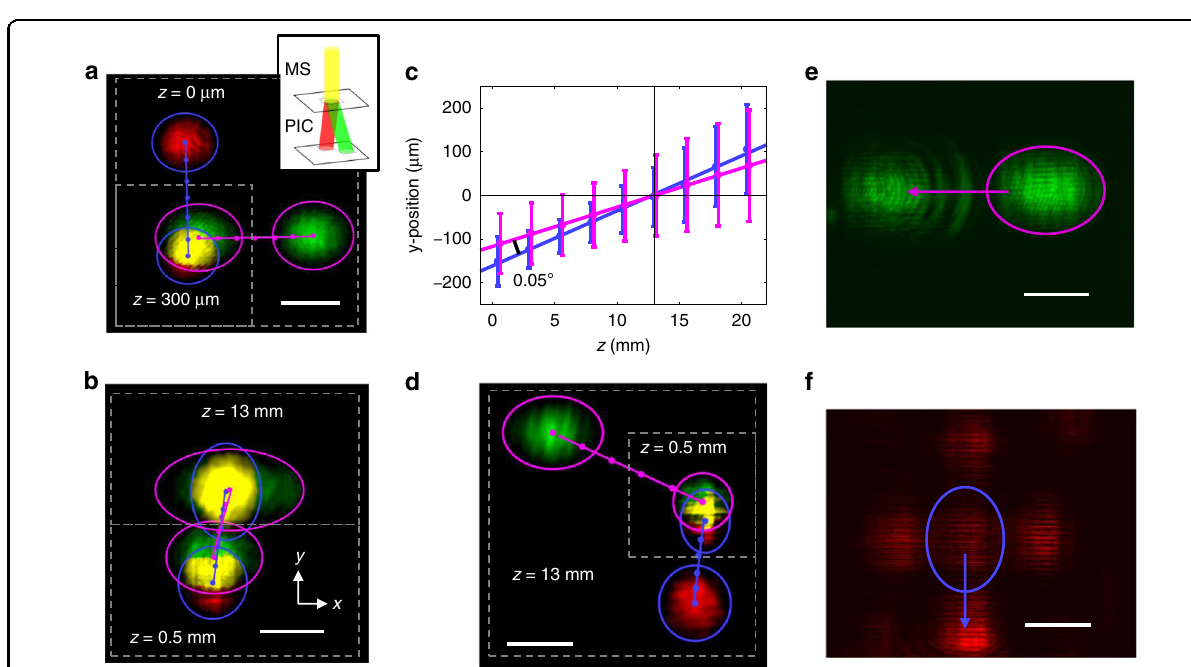
Fig. 4 Lattice and clock beam performance. a Composite image of the lattice (green) and clock (red) beams taken at the PIC surface (z = 0 µm, large white box) and the intersection height (z = 300 µm, small white box). The inset illustrates the ideal performance of the beam combiner. b Composite image of the lattice and clock beams measured at the MS surface (z = 0.5 mm, bottom white box) and near the MOT center (z = 13 mm, top white box). c Measured y-position of the lattice (magenta) and clock (blue) beams as a function of height above the MS. The vertical bars of the data points correspond to the average w 0 of the beams. d Composite image of the lattice and clock beams (similar to b ) for a MS that is mismatched by 1° in wedge correction. e Image of the desired negative-order lattice beam (circled) and zero-order beam (at arrow) taken 350 µm above the MS. f Image of the desired negative-order clock beam (circled), zero-order beam (at arrow), and other order beams taken at 200 µm above the MS. All images are false colored, and all scale bars are 100